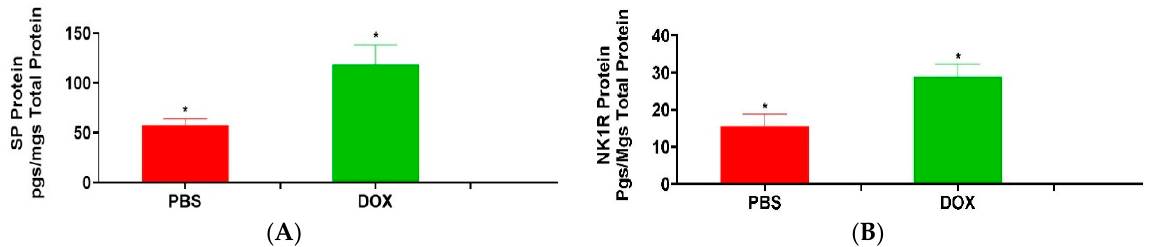
Figure 1. Doxorubicin treatment induces significant increases in the cardiac levels of, substance P and its high affinity receptor, NK1R. Effect of doxorubicin treatment on ( A ) SP levels and ( B ) NK1R levels in the heart. Both SP and NK1R levels were significantly increased in the hearts of DOX treated mice compared to that of the vehicle treated group (*, both p < 0.05, Student’s t